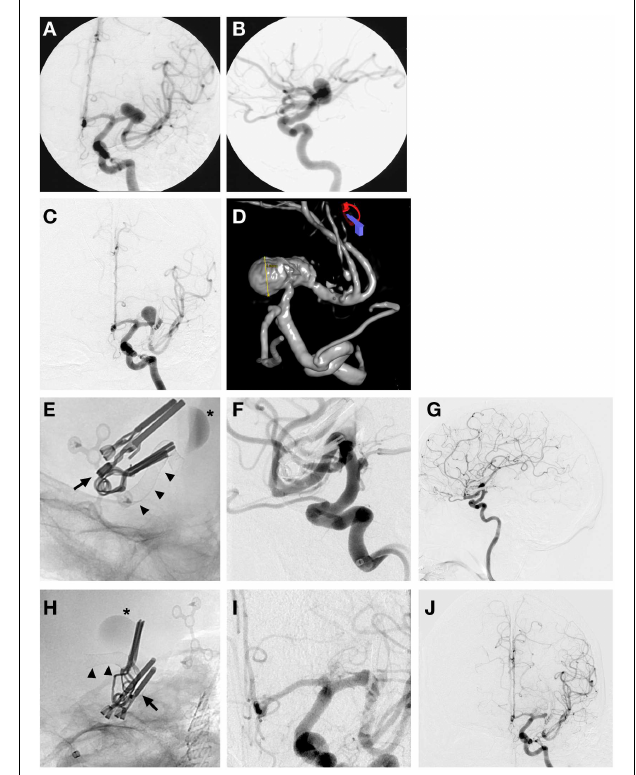
FIGURE 4 | Case 4 . (A) AP left ICA angiographic image demonstrating a wide-based large left MCA M1 segment aneurysm; (B) left MCA